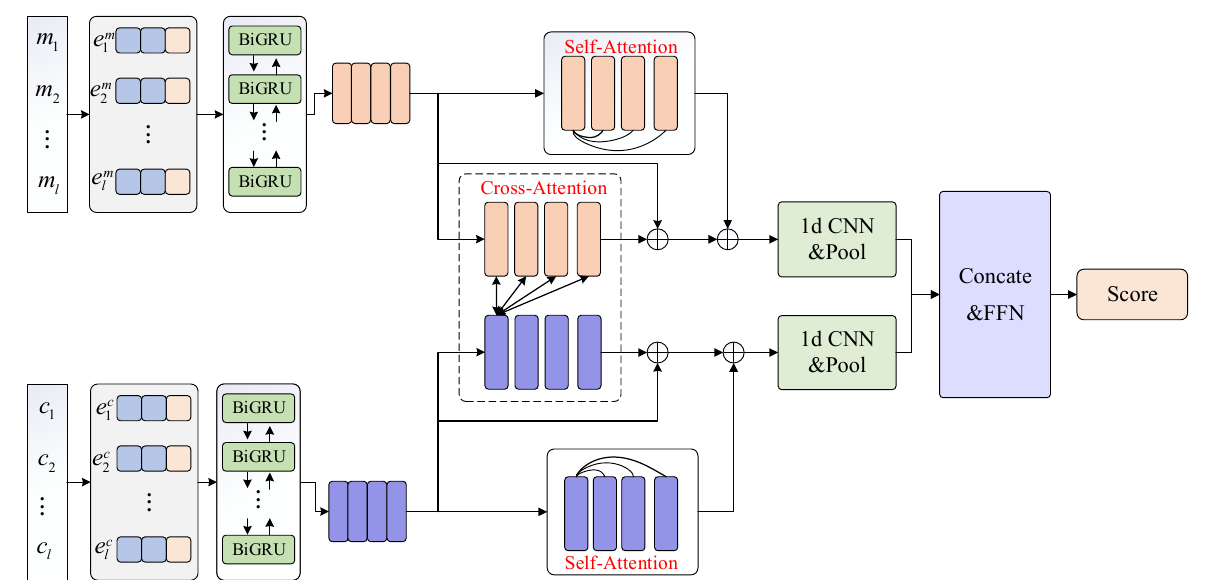
Figure 1. The architecture of our candidate ranking model.